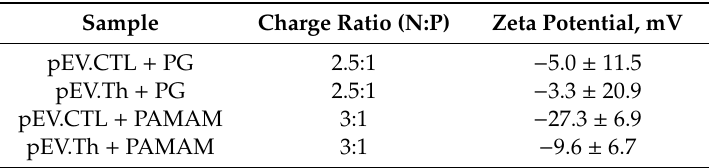
Table 2. Surface charge of DNA-carrier